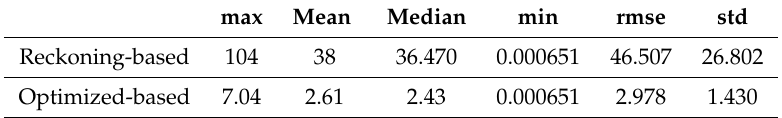
Table 4. The comparison of the absolute pose errors of trajectories in experiment III (in meters). max Mean Median min rmse std Reckoning-based 104